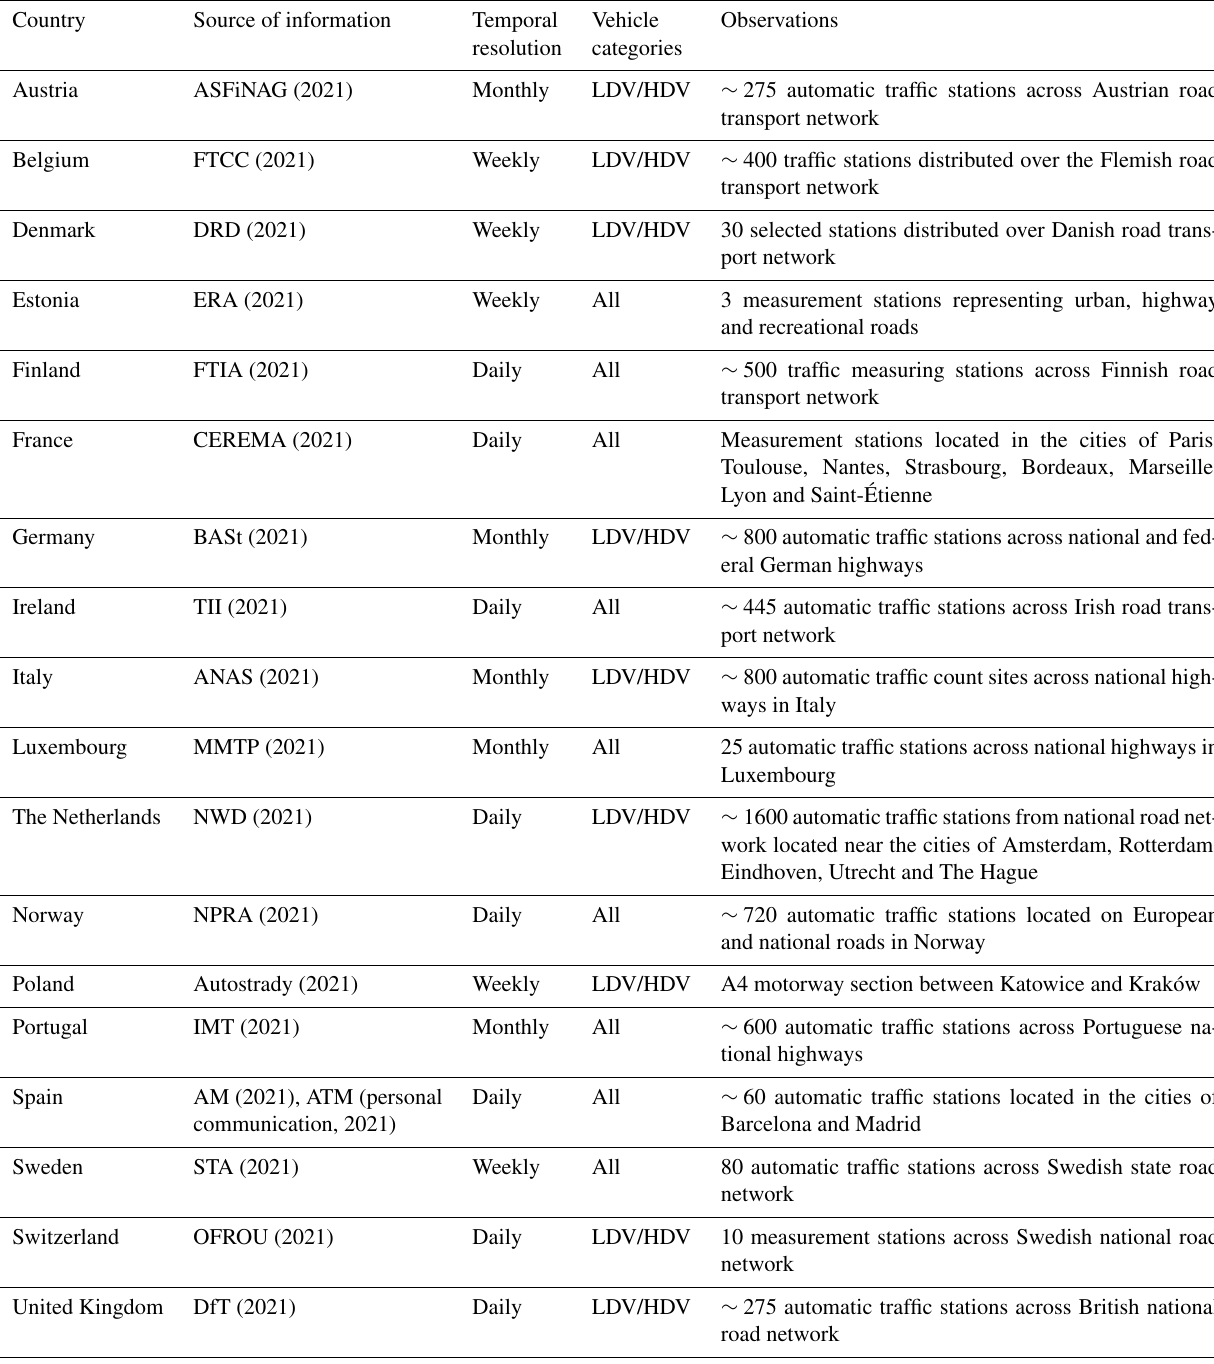
Table A1. Summary of the European traffic count datasets considered, including country, source of information, temporal resolution of the traffic counts, vehicle categories (LDV, light-duty vehicle; HDV, heavy-duty vehicle) and number of